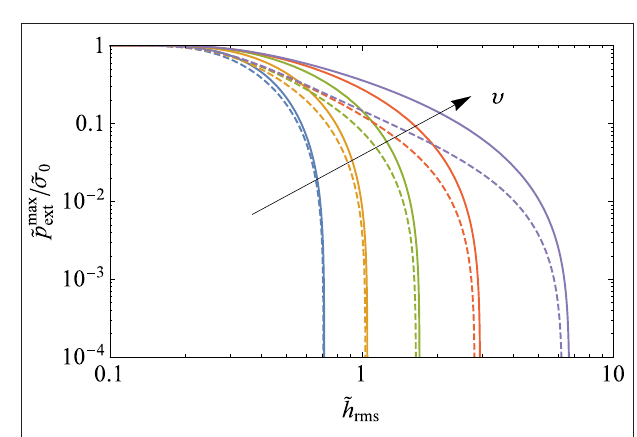
FIGURE 4 | External pressure